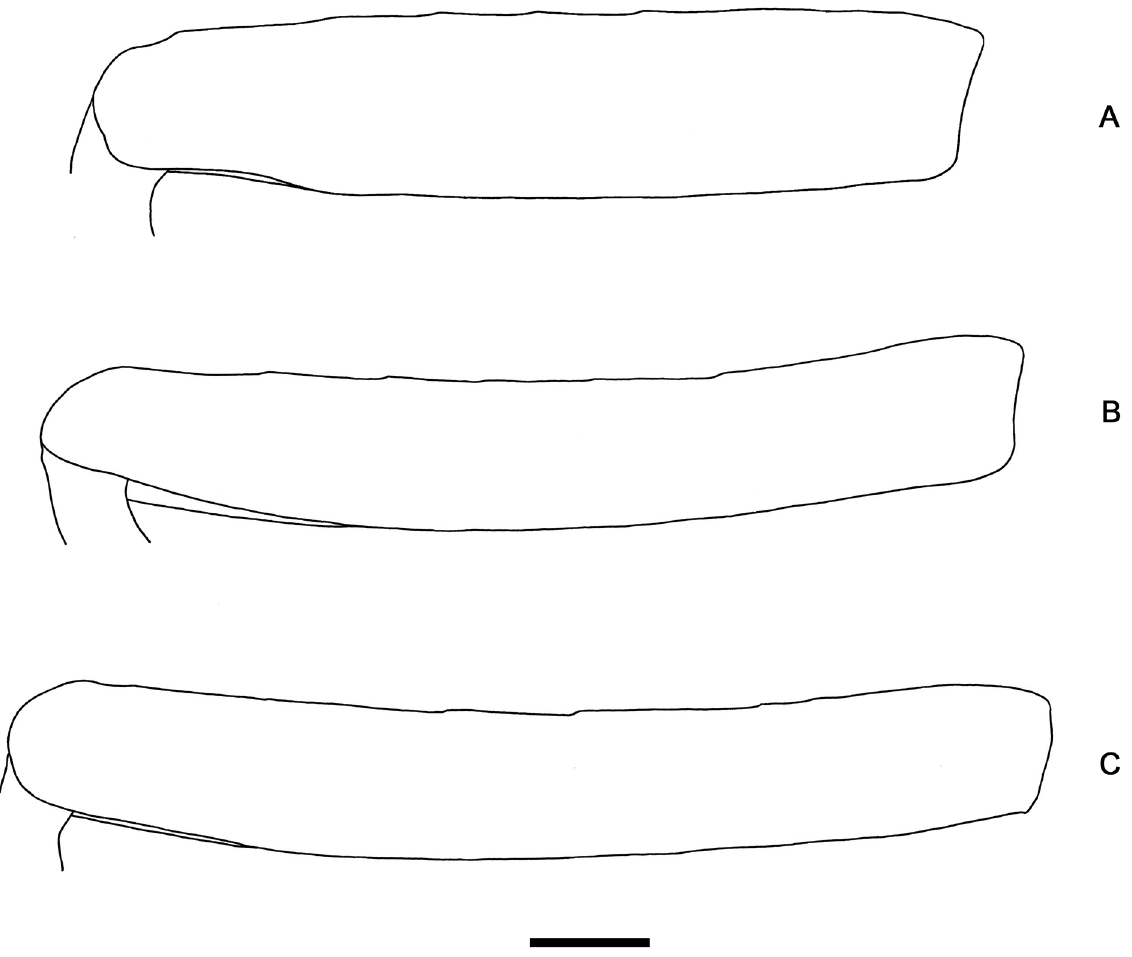
Fig. 4. Procerobaetis leptobranchius gen. et sp. nov., larval morphology. A . Foreleg femur. B . Middle leg femur. C . Hind leg femur. Scale bar: 0.1